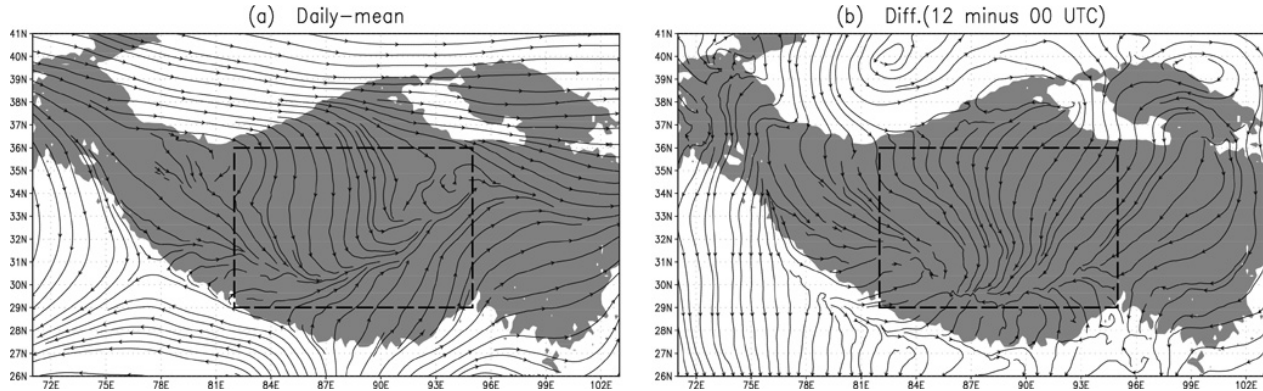
Fig. 5. 500hPa streamline: (a) daily-mean, (b) difference between 12:00 and 00:00UTC. The shaded areas are above 3000m and the dashed rectangles represent the central plateau.